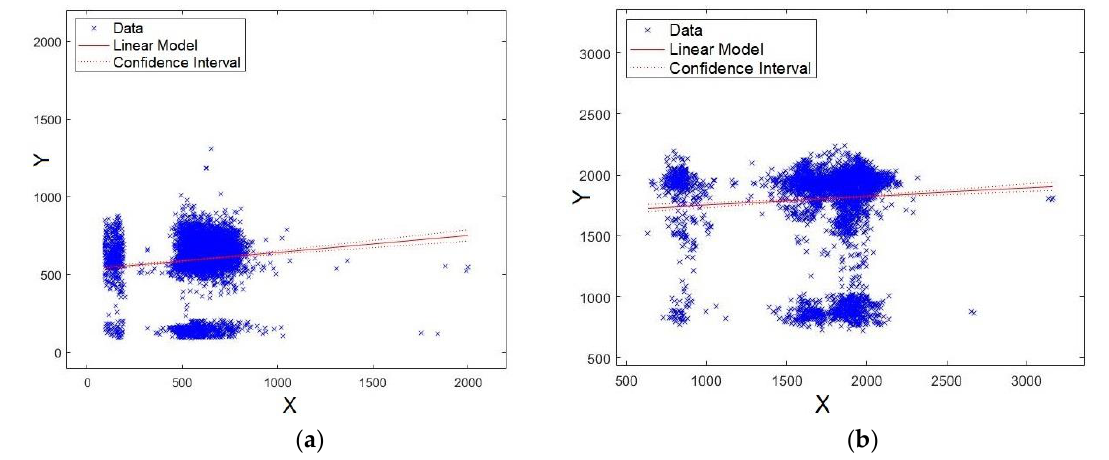
Figure 11. XY straight line for : (a) formant F0 and (b) formant F1 .